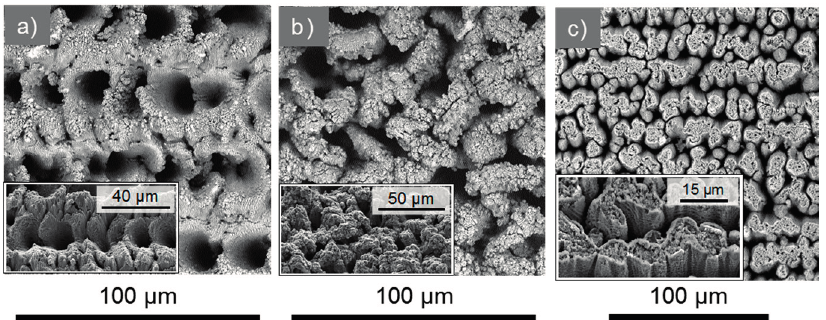
Figure 9. ( a ) Hole structure on Ti. Inset: high magnification image of sample tilted at an angle of 25°. ( b ) Chaotic and rugged structure on Ti. Inset: high magnification image of sample tilted at an angle of 40°. ( c ) Maze structure on Al. Inset: high magnification image of sample tilted at an angle of 25°